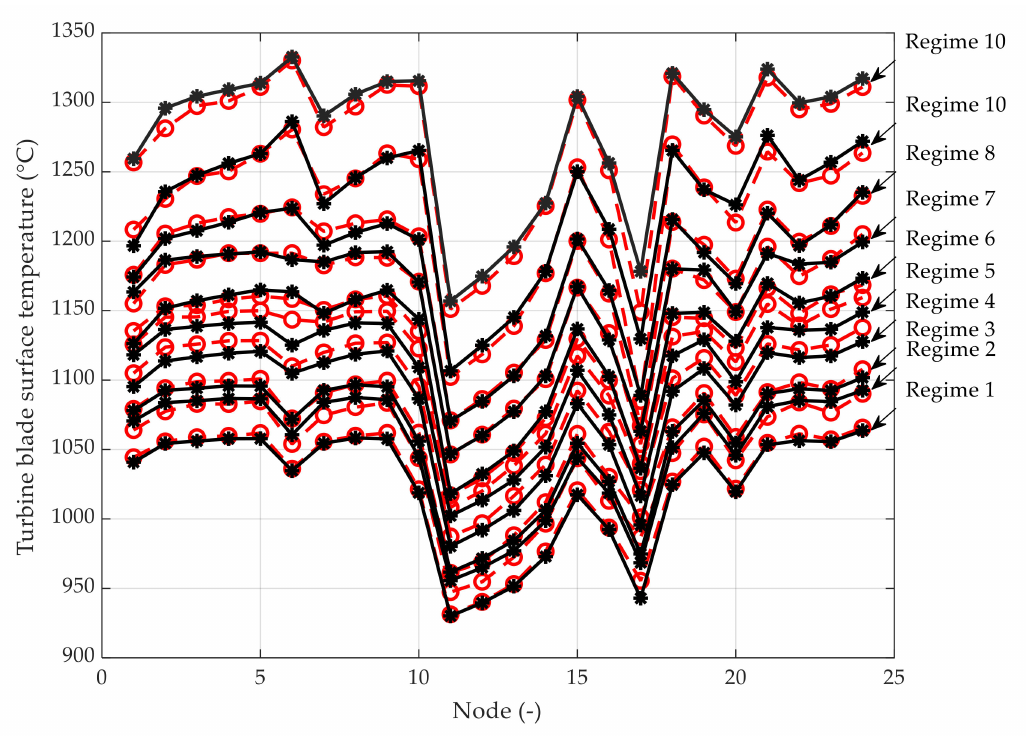
Figure 8. Predicted temperatures in specific nodes representing the chosen positions on the surface of the turbine blade.